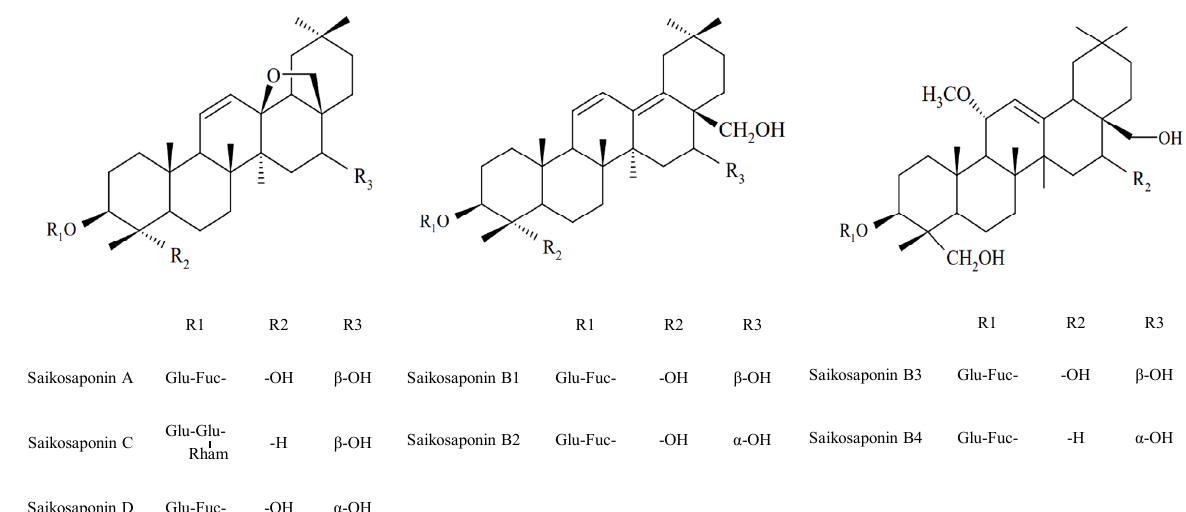
Figure 1. Structure of various saikosaponins.